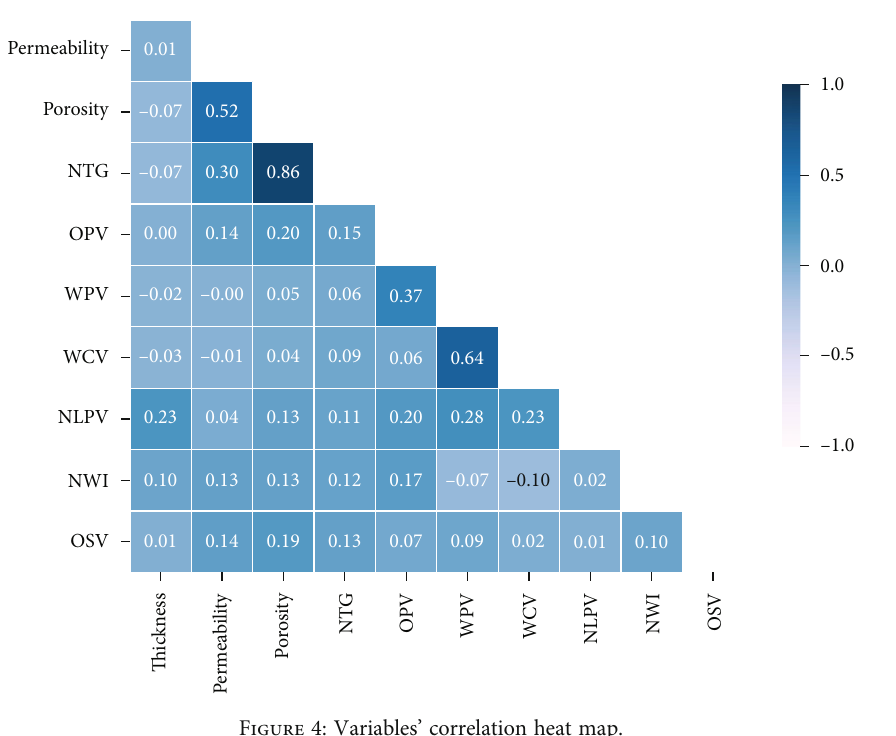
Figure 4: Variables ’ correlation heat map.